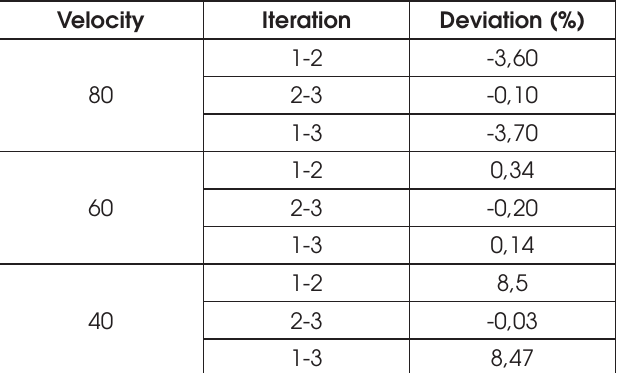
Difference between the iterations using the SRSS method